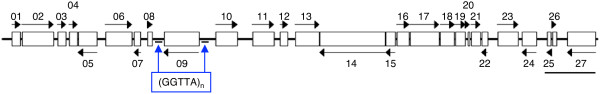
Schematic organization of putative genes on the kuruma shrimp BAC clone Mj024A04. Twenty-seven putative genes (boxes) and inter-genic regions (lines) are indicated with transcriptional orientation (arrows). Putative gene 09 is flanked with large GGTTA repeats (double lines).